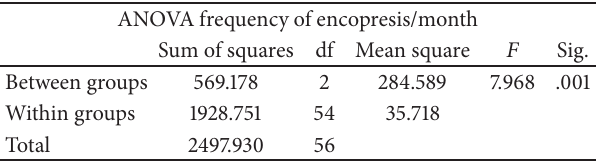
Table 3: Frequency of encopreticepisodes and relationship with the school